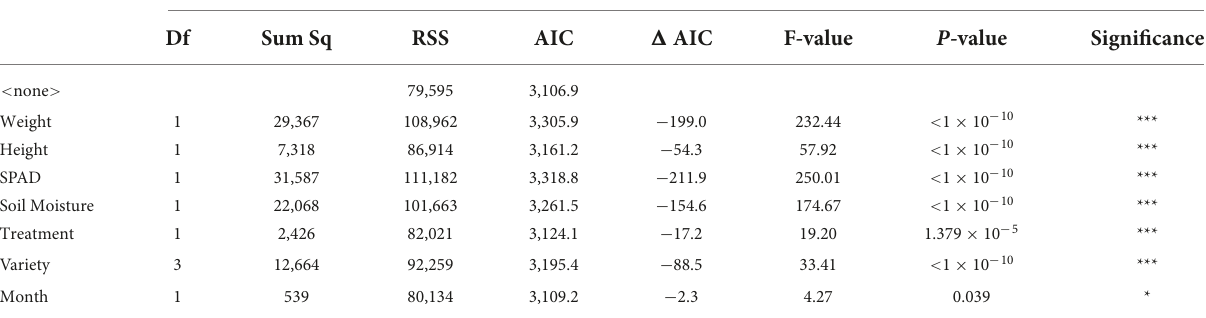
TABLE 4 Model statistics and significance levels for the linear model in regards to the first PCA axis (Color Intensity) isolated from the color analysis of the harvested perennial ryegrass material.